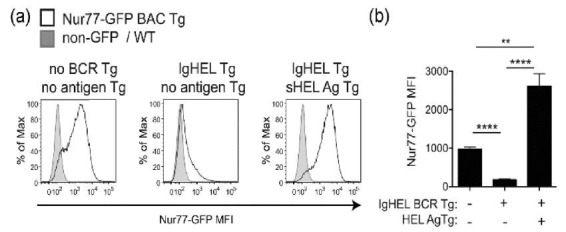
Antigen is necessary and sufficient for Nur77-eGFP expression in B cells; IgHEL-sHEL interaction drives higher Nur77-eGFP expression than the wild type BCR repertoire.Panel (A) take from Manuscript Figure 1A. Panel (B) depicts quantification of mean Nur77-eGFP MFI -/- SEM in N=5 biological replicates.